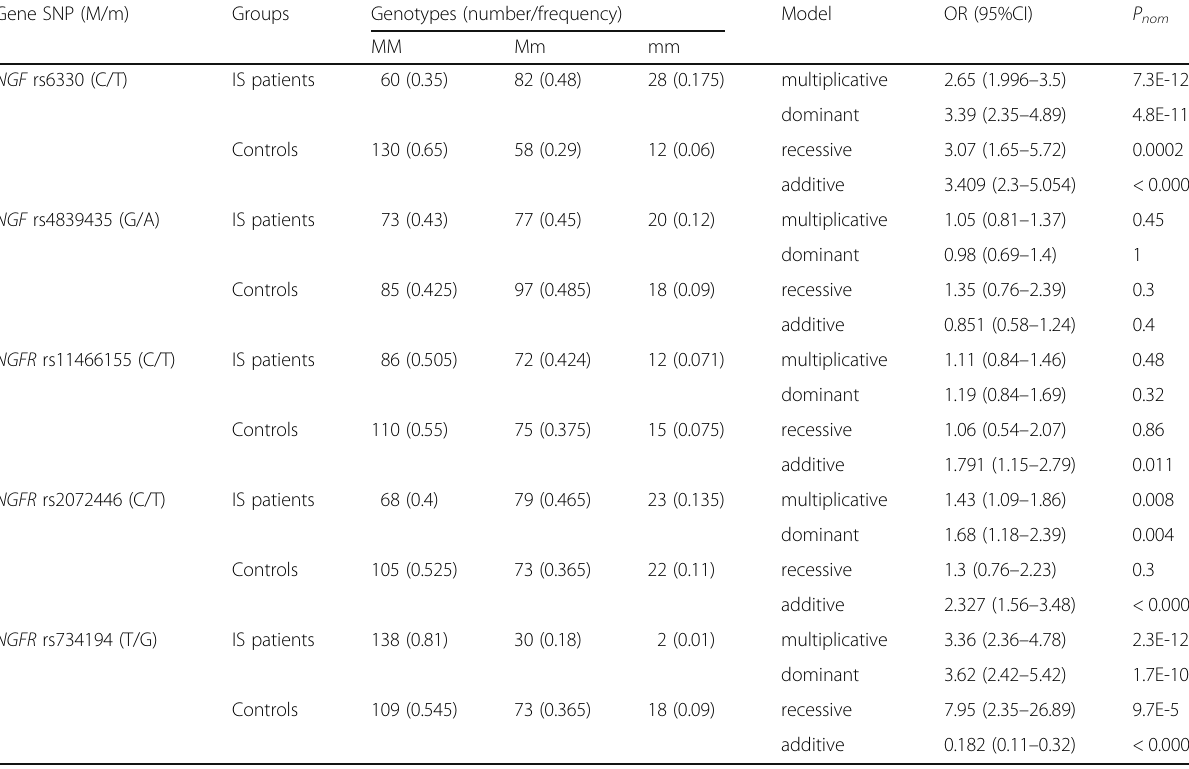
Table 3 Association of the NGF and NGFR genes SNPs with IS risk under different models Gene SNP (M/m) Groups Genotypes (number/frequency)